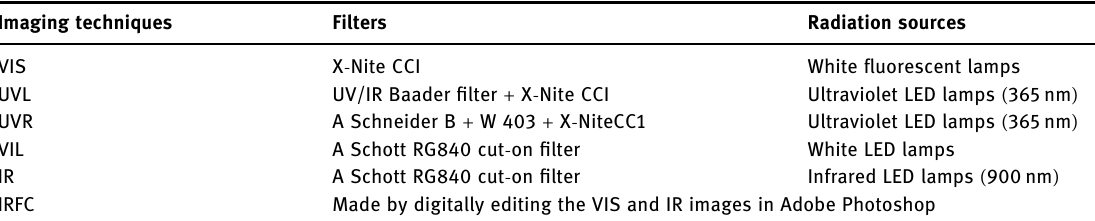
Table 2: A summary of the fi lters and radiation sources used for imaging techniques Imaging